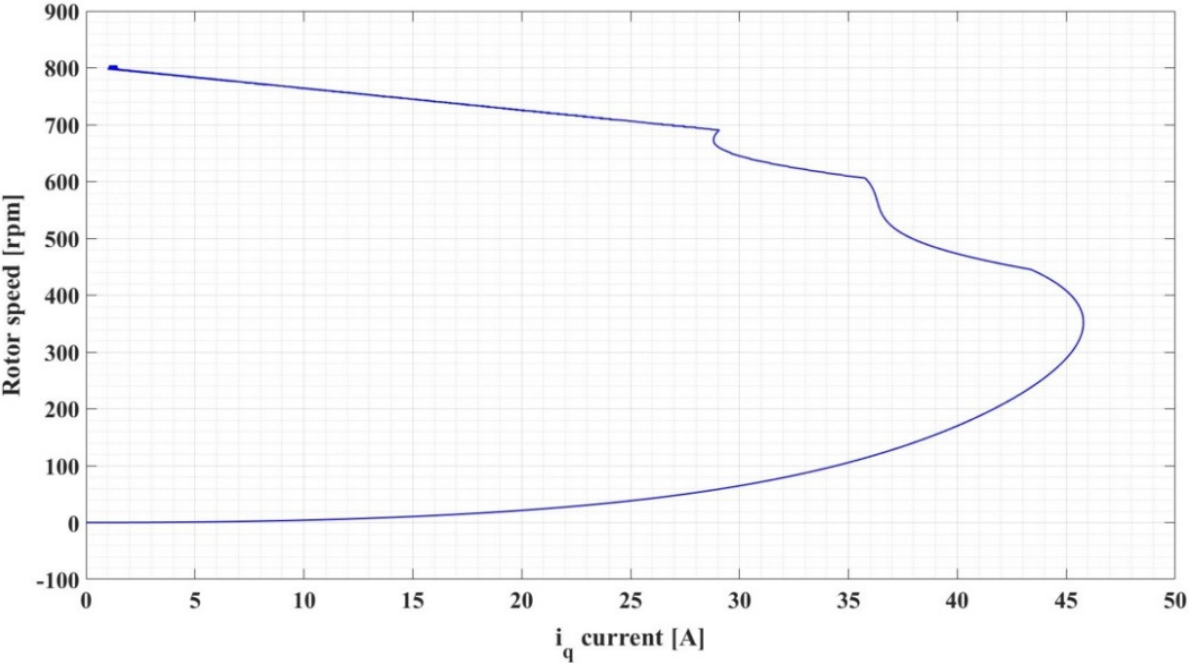
Figure 30. Image of the phase plan for PMSM variable structure with switching signal type 2: rotor speed versus i q current ( ω ref = 800 rpm).